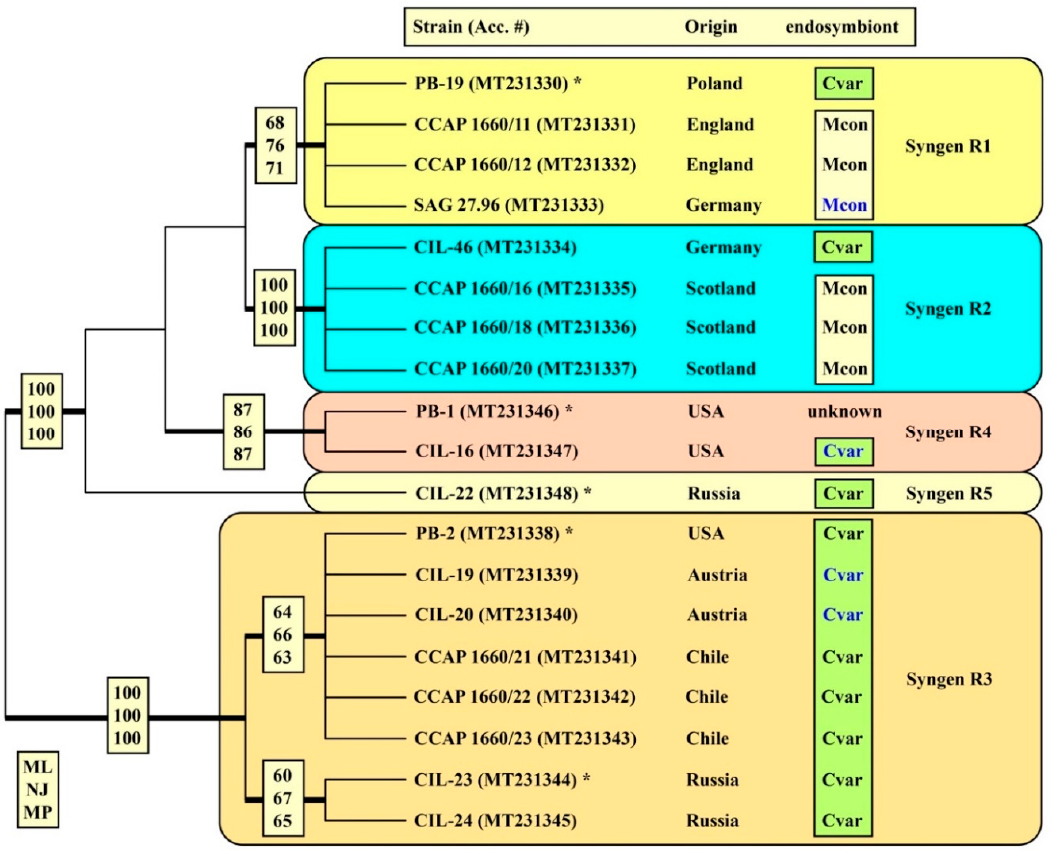
Figure 5. Molecular phylogeny of the Paramecium bursaria based on SSU and ITS rDNA sequence comparisons. The phylogenetic tree shown was inferred using the maximum likelihood method based on the datasets (2197 aligned positions of 19 taxa) using computer program PAUP 4.0a167. For the analyses, the best model was calculated by PAUP 4.0a167. The setting of the best model was given as follows: GTR + I (base frequencies: A 0.2994, C 0.1832, G 0.2278, T 0.2896; rate matrix A-C 2.4955, A-G 4.2183, A-U 4.9756, C-G 0.7513, C-U 9.6155, G-U 1.0000) with the proportion of invariable sites (I = 0.9303). The branches in bold are highly